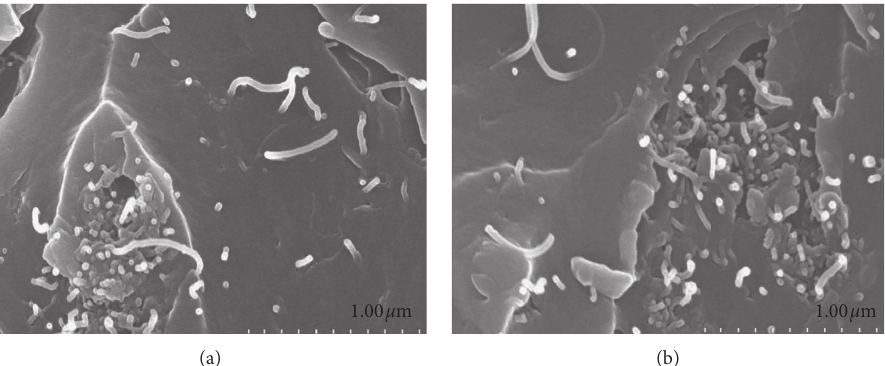
Figure 9: FE-SEM images of nanocomposites: (a) fly ash/MWCNTs/epoxy: 50 wt.% fly ash/0.03 wt.% MWCNTs/epoxy and (b) fly ash/ MWCNTs/epoxy: 50 wt.% fly ash/0.05 wt.% MWCNTs/epoxy.